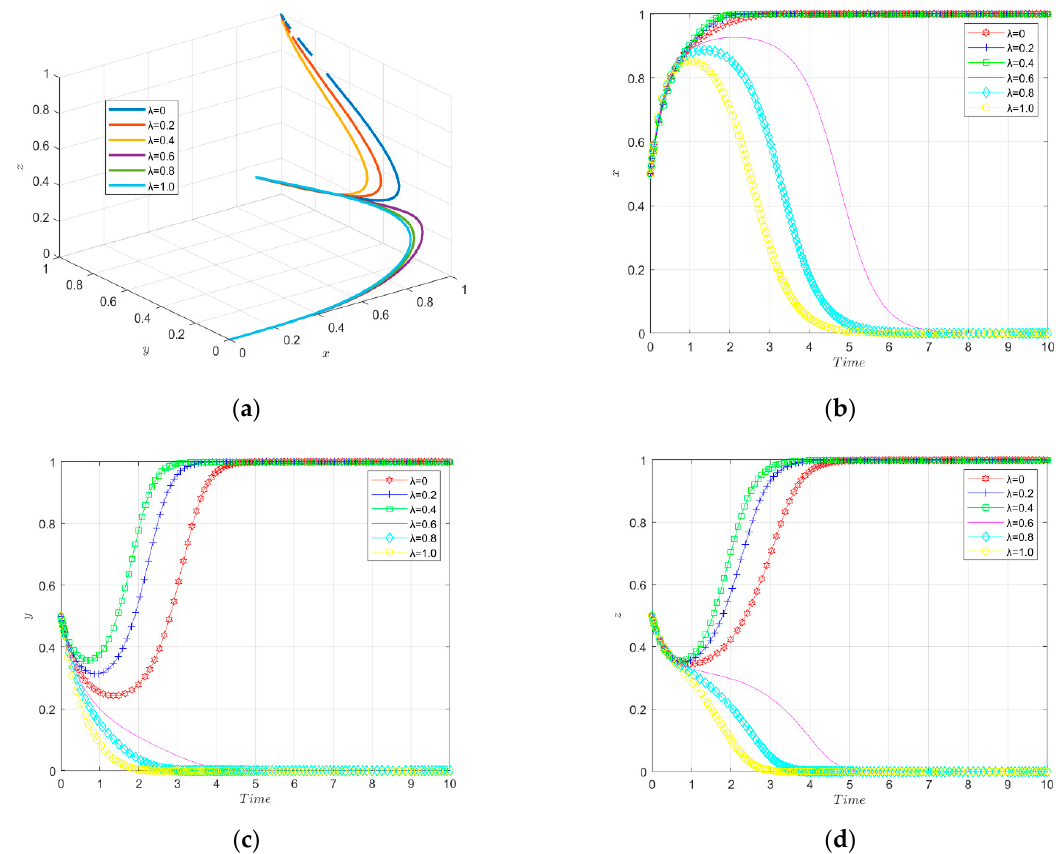
Figure 14. ( a )Triadic evolutionary trajectory under λ changes. Evolutionary trajectories of enterprise ( b ), government ( c ) and financial institutions ( d ) under different informal environmental regulation enforcement intensities.